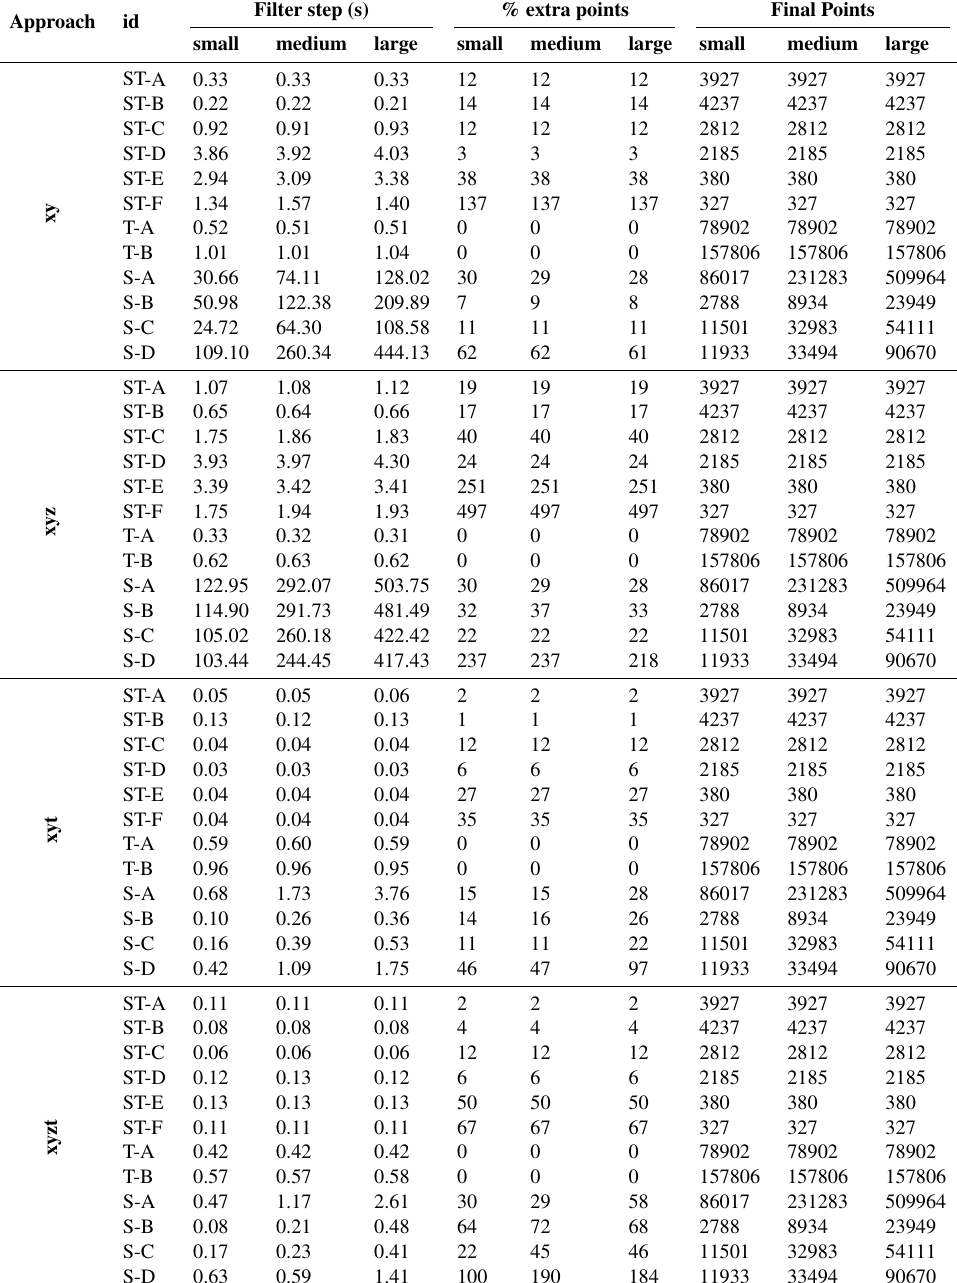
Table 5: Query response times, the percentage of false hits compared to the actual number of points and the points returned by the